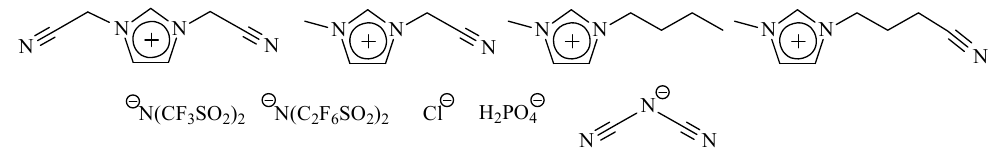
Figure 3. Structure of some dialkylimidazolium salts used in [137,138].